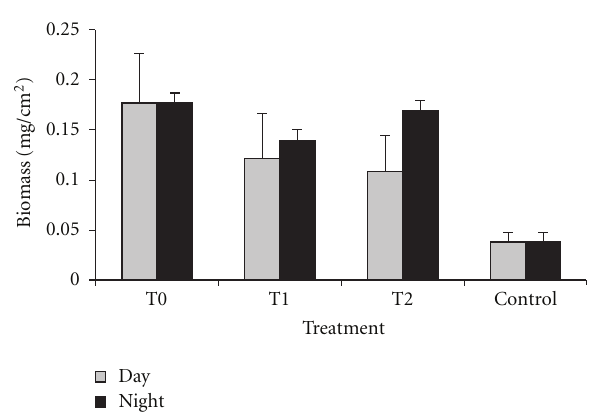
Figure 2: Organic matter as measured in February 2008. Treat- ments consisted in caged settlement plates (T0 n = 26), noncaged settlement plates (out n = 26), and settlement plates removed from the cages and exposed to grazing for 2h (T1 n = 18) and 11 h (T2 n = 18). Grey columns: day exposure, black columns: night